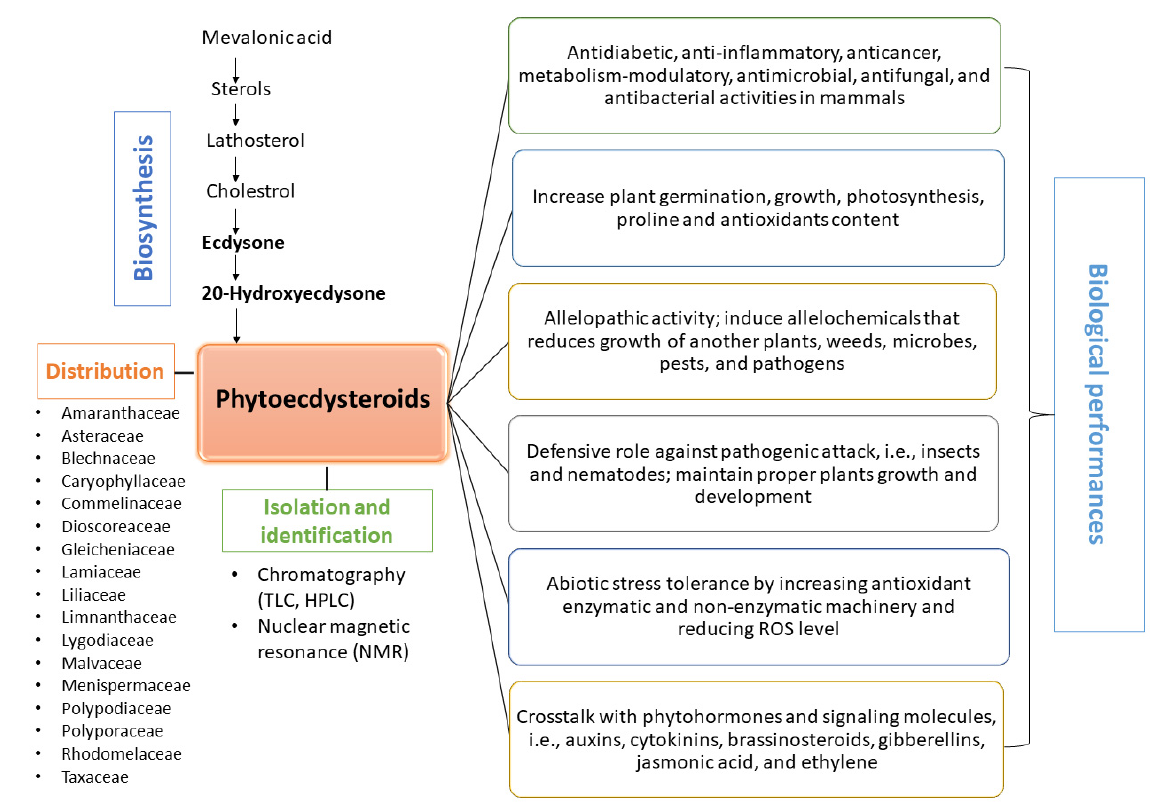
Figure 4. Pictorial representation of distribution, isolation, biosynthesis, and biological roles of phytoecdysteroids.